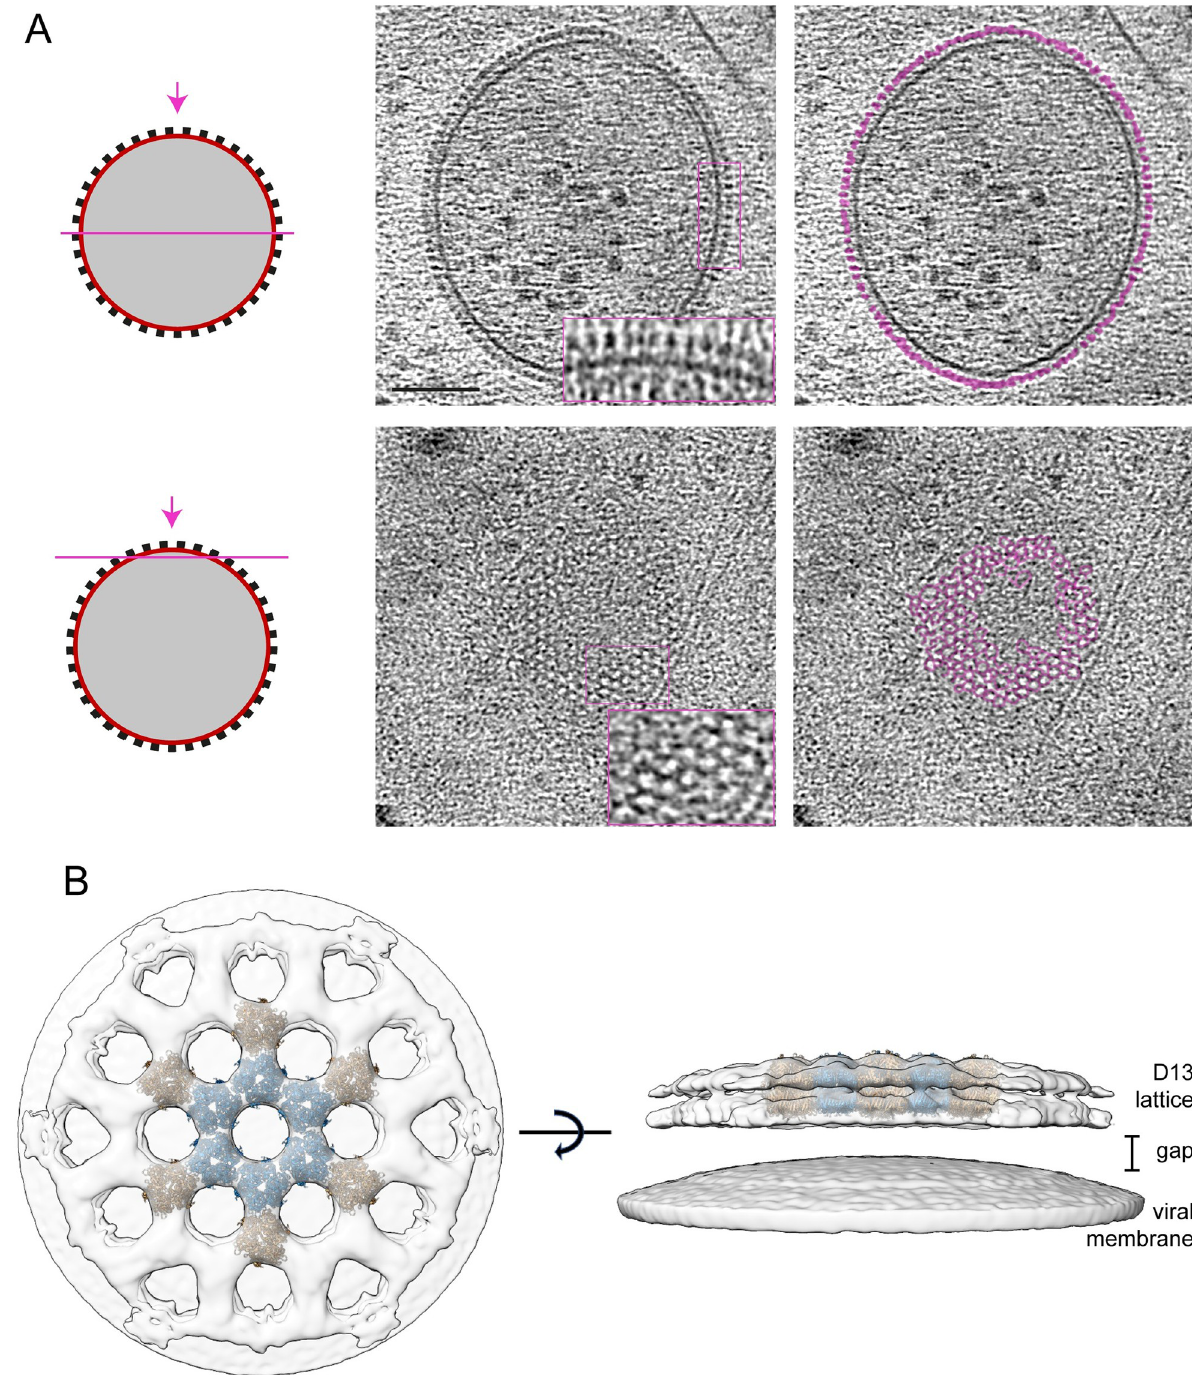
Fig 3. In situ structure of the D13 lattice. ( A ) Tomogram section as indicated in the schematic on the left through the middle and top of a representative IV (see S4 Movie). The densities corresponding to the D13 lattice are coloured in magenta in the right panels and show pseudohexagonal organisation. Scale bar = 100 nm. ( B ) Map based on STA of D13 and the underlying IV membrane from a top (left) and a side (right) view with fitting of coordinate models of D13 trimers (PDB 7VFE) shown in blue/brown. IV, immature virion; STA, subtomogram averaging.